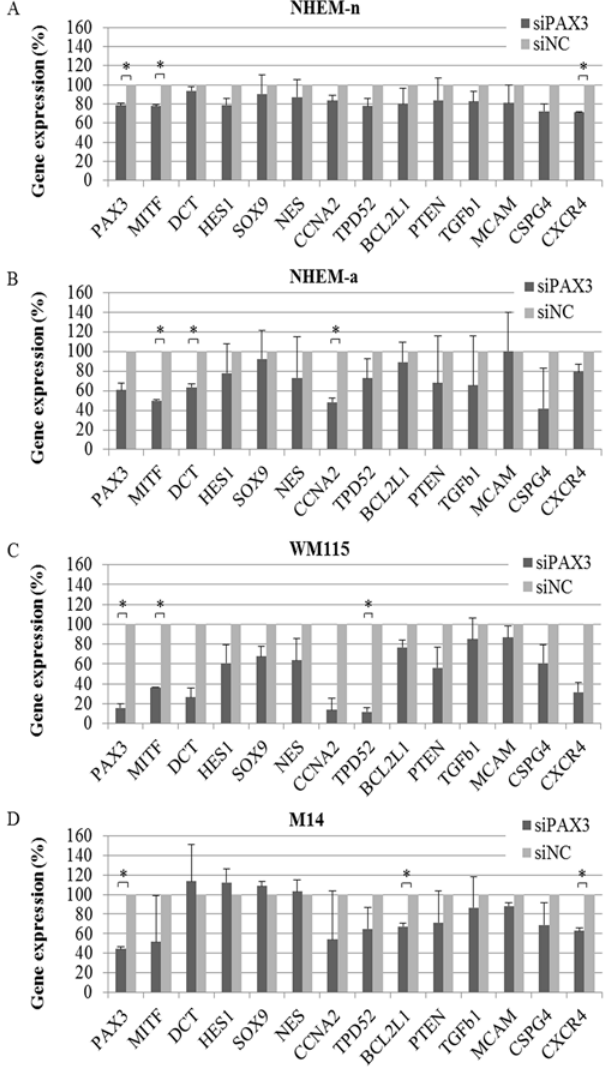
Fig 1. Target gene expression following PAX3 silencing. Remaining expression levels (%) of PAX3 downstream target genes in melanocytes (NHEM-n and NHEM-a (I)) and melanoma cells (WM115 and M14) assessed two day post-transfection with PAX3 siRNA. Cells were treated with 10 μ M siPAX3#1 (s224172, Ambion) alone, with consistent results observed across several independent experiments. Expression levels of downstream target genes were normalised to 18S ( Δ Ct) and calculated relative to the negative control siRNA ( ΔΔ Ct). Each silencing experiment was performed with a biological duplicate.